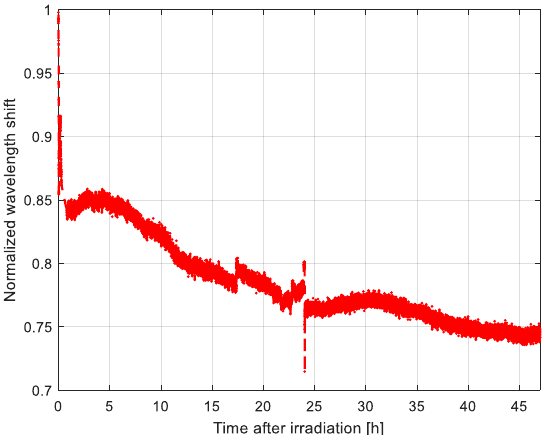
Figure 8. Recovery of the wavelength shift after the irradiation measured using the GC-5000 setup. The wavelength shift is divided by the value at the end of the irradiation (normalized), whereas the time axis is reported starting at the same instant.